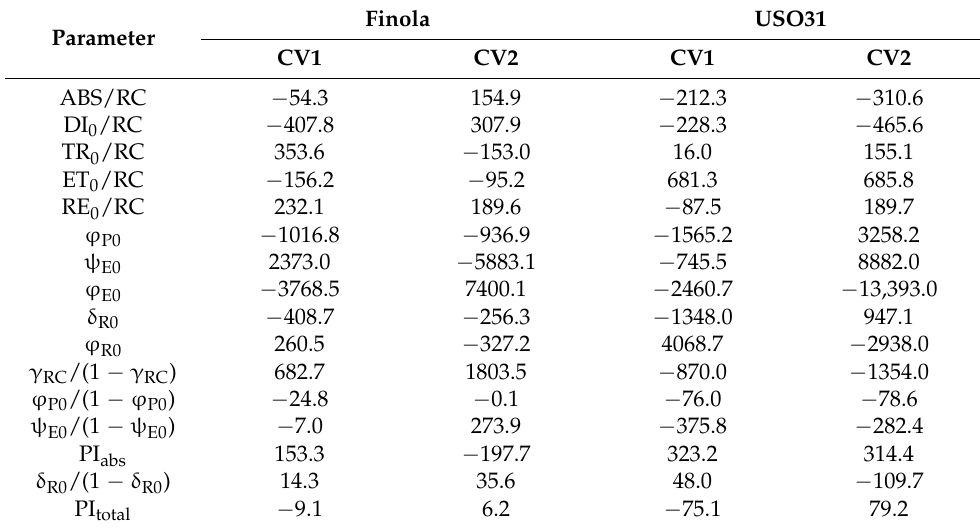
Table 1. Coefficients of the first two canonical variates (Figure 3) in Finola and USO31 cultivars. Parameter